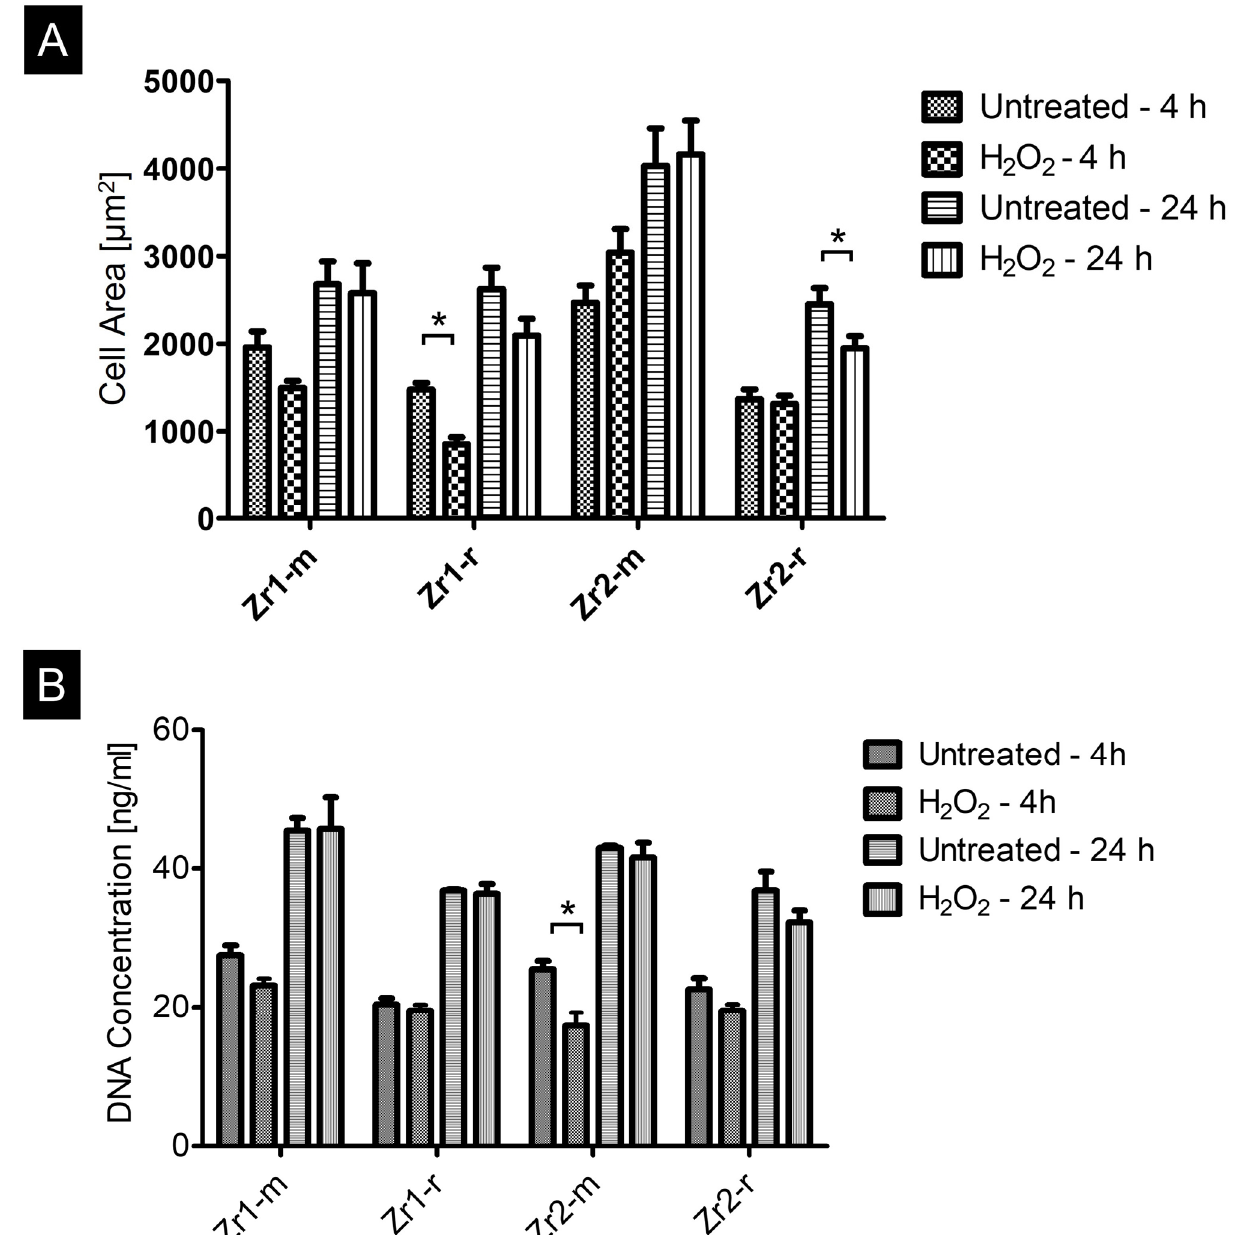
Figure 4. ( A , B ) Comparison of the cell area ( A ) and the DNA concentration ( B ) on untreated and H 2 O 2 -treated zirconia surfaces after 4 h and 24 h of culture. The image analyzer tool of the fluores- cence microscope was used to perform cell morphometric measurements. Data are mean ± SD (n = 81) evaluated from 27 cells from each disc. Statistical significances with p < 0.05 are labeled with “*” in the graphs.